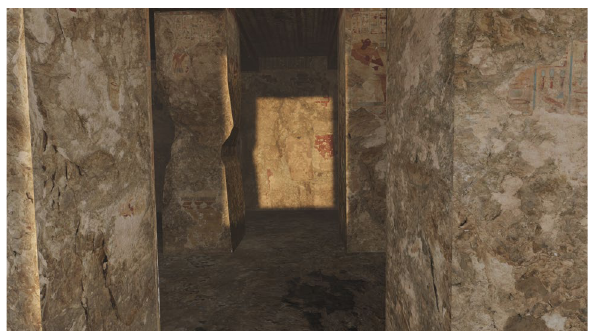
Figure 10 . The decimated model in Blender.